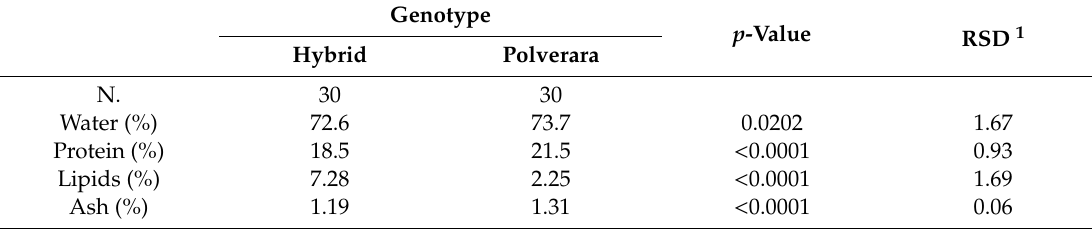
Table 2. E ff ect of chicken genotype (Hybrid vs. Polverara) on the proximate composition of leg meat. Genotype p -Value